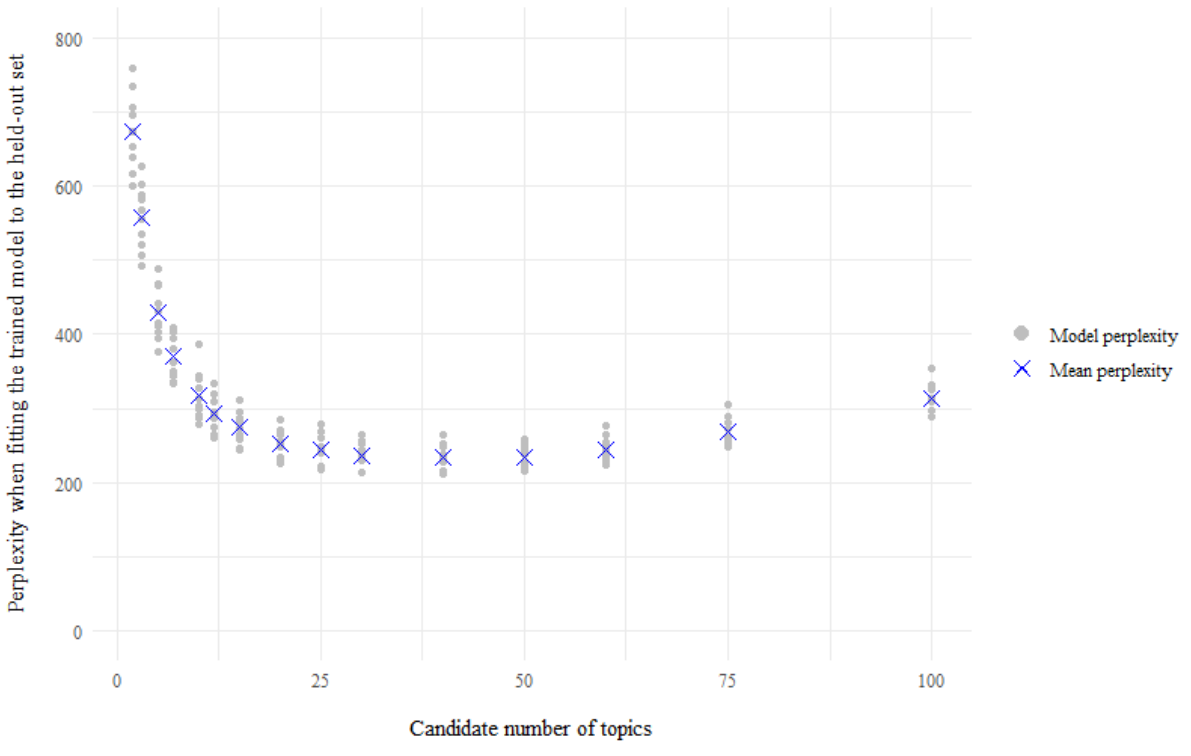
Figure 1. Perplexity scores for the models—LifeInfo store loyalty card question, 10-fold cross-validation of topic modelling to establish the optimal number of topics for latent Dirichlet allocation.